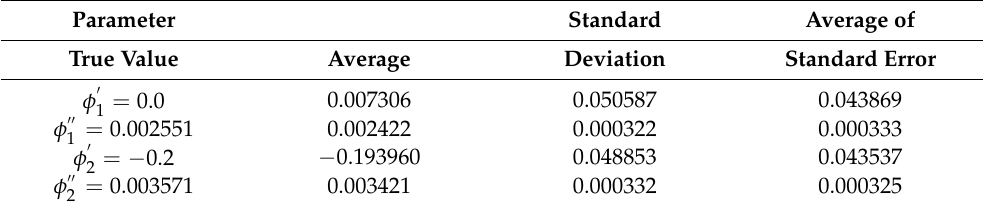
Table A1. Theoretical values of the parameters, averages and standard deviations of the estimates across simulations and averages across simulations of the estimated standard errors φ (cid:48) φ (cid:48)(cid:48) for the tdAR(2) model described above for n = 400 and 999 replications (out of 1000). 2